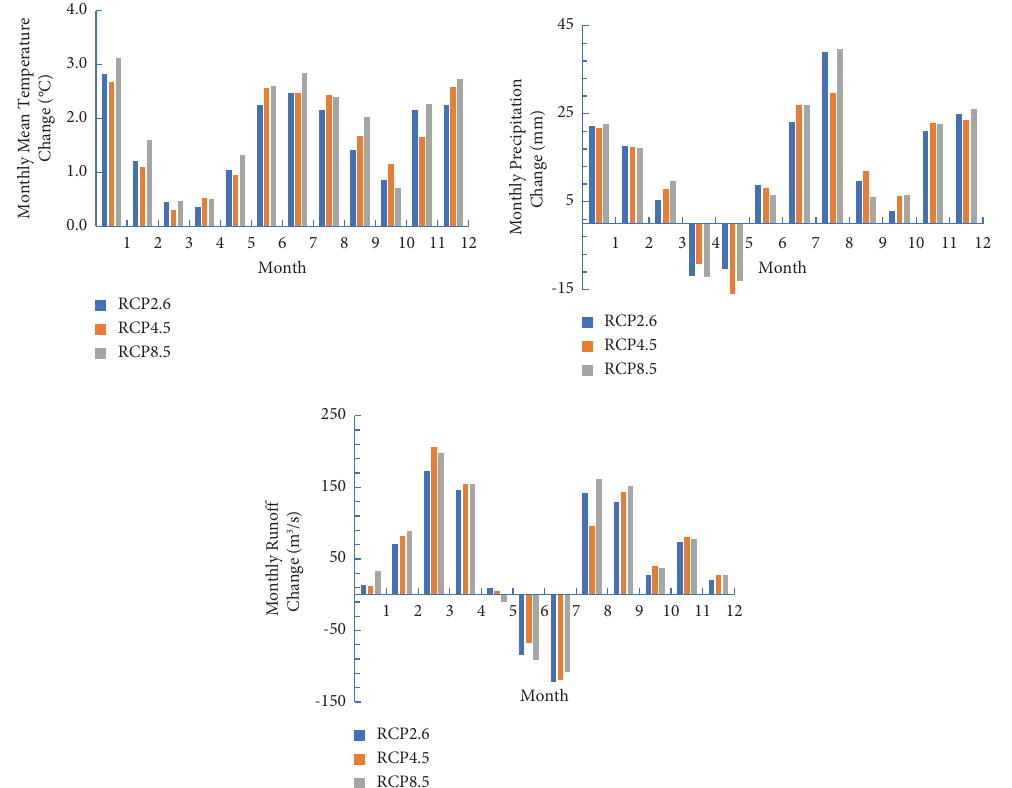
Figure 4: Changes in monthly average temperature, precipitation, and runof compared with the base year under RCP2.6, RCP4.5, and RCP8.5 from 2021 to